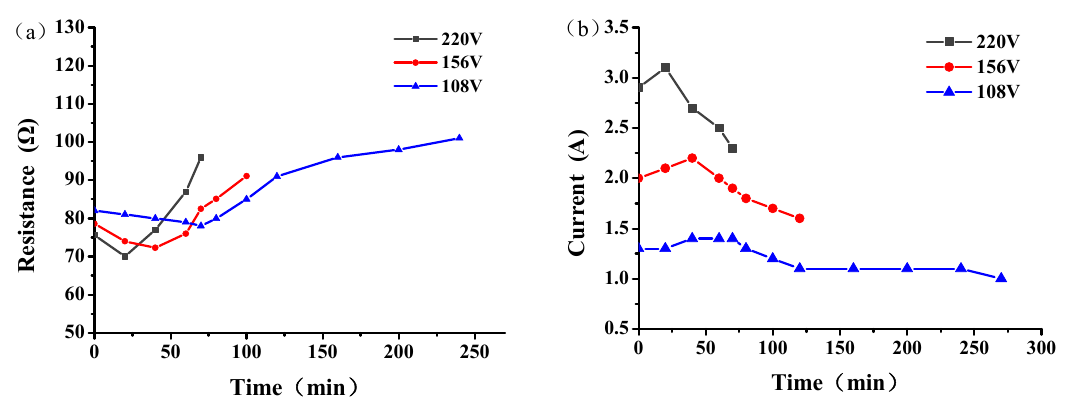
Figure 10. Resistance ( a ) and current ( b ) of graphene composite conductive concrete slabs under different voltages.